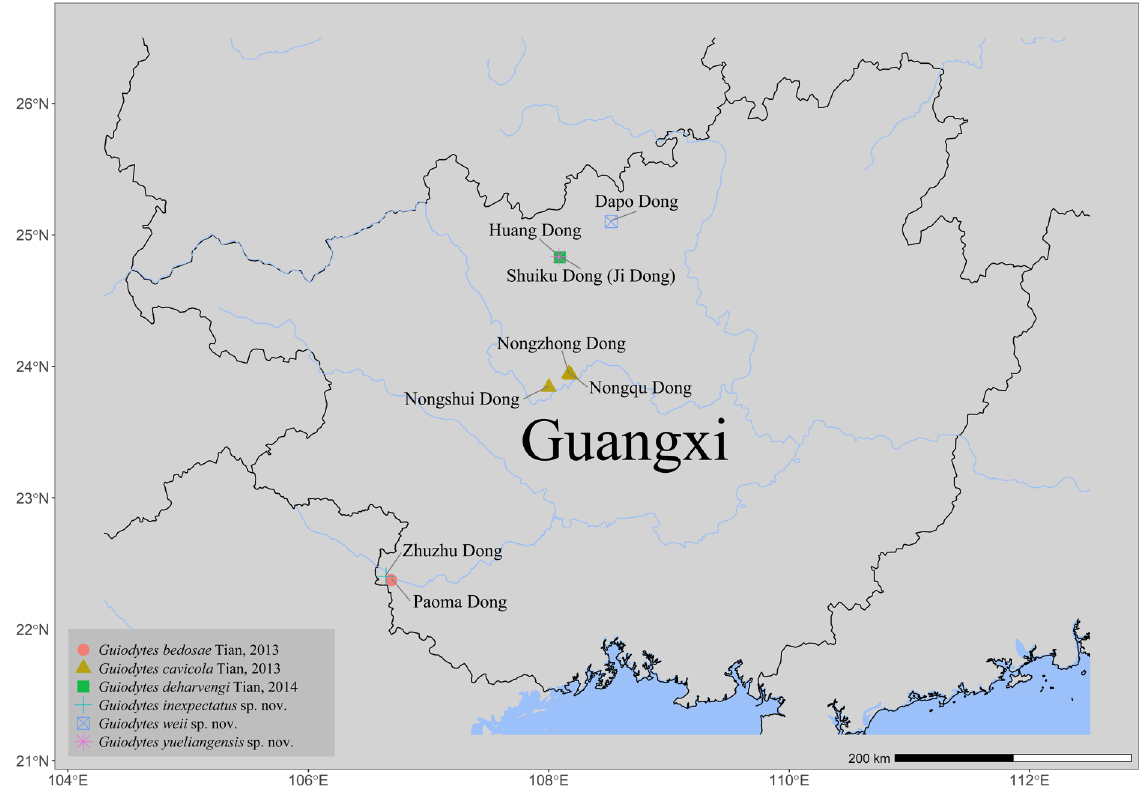
Fig. 1. Map of Guangxi (China) with the occurrences of Guiodytes Tian,